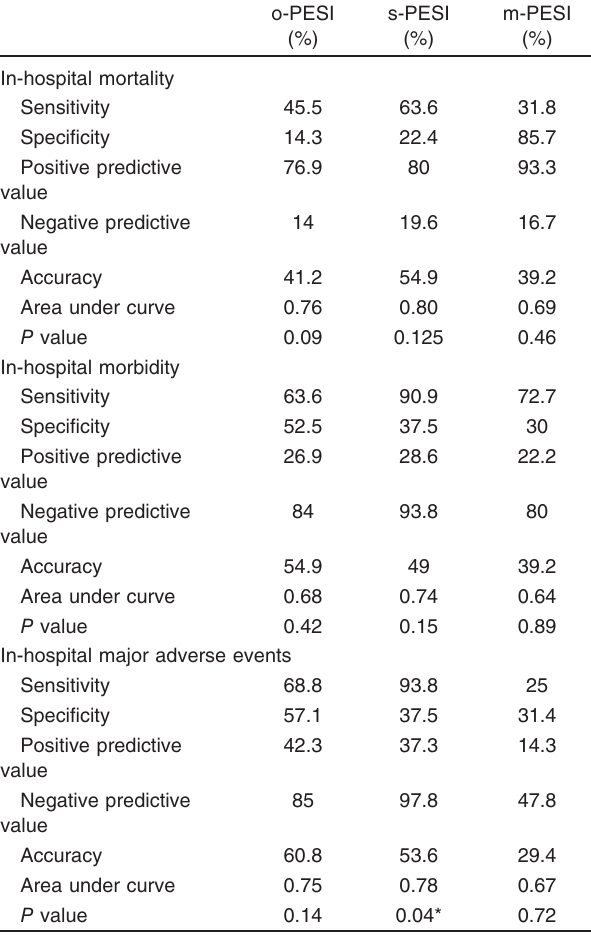
m-PESI, modified pulmonary embolism severity index; o-PESI, Original pulmonary embolism severity index; s-PESI, simplified pulmonary embolism severity index. * P <